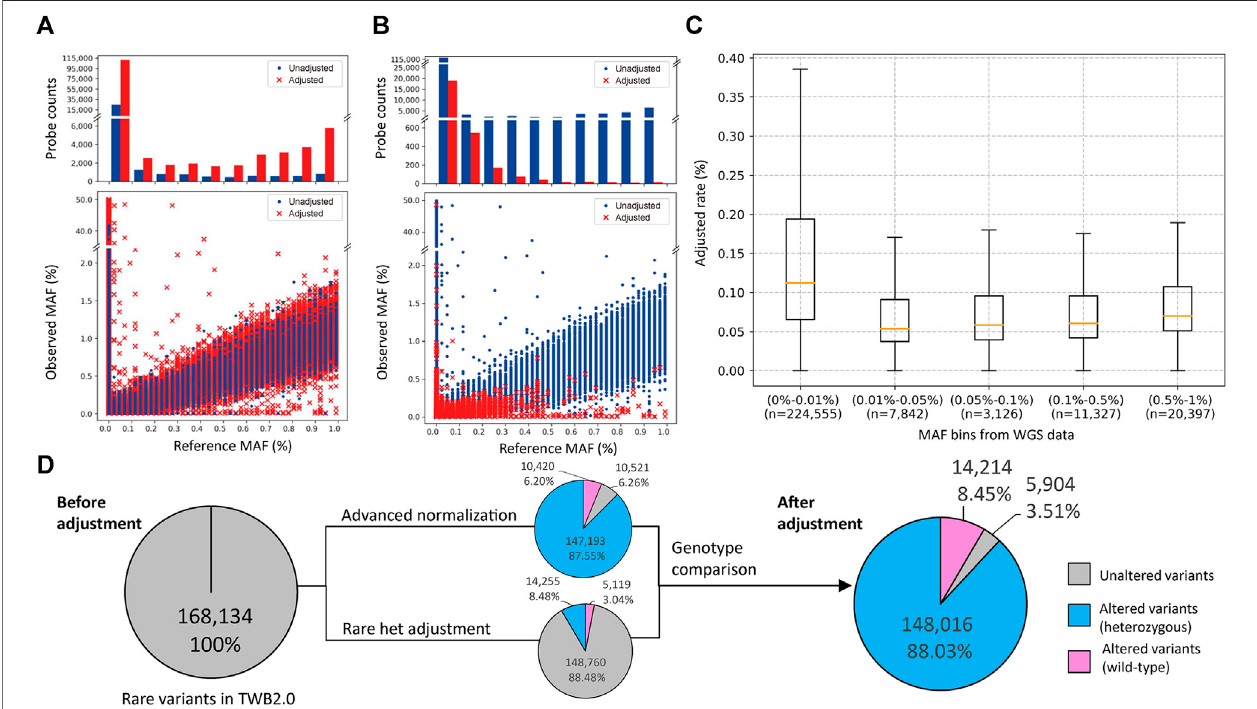
FIGURE 2 | Minor allele frequency (MAF) distribution and probeset count after performance of the rare variant quality-control procedure. (A,B) The former is the MAF distribution after using the advanced normalization method,and thelatter is theMAF distribution after using the rare hetadjustmentmethod. The upper plotshows the number of probesets adjusted (red bar) or unadjusted (blue bar) by this algorithm. The bottom plot shows the distribution of MAFs between the single-nucleotide polymorphism (SNP) array and sequencing data. Adjusted data points are marked with a red “ × ” , and unadjusted data points are marked with a blue dot. (C) Box plot of the adjusted rate per MAF bin based on sequencing data. (D) Number of rare variants with at least one heterozygous call in the original data, and after advanced normalization and rare het adjustment. Variants not adjusted by our algorithms are represented as a gray slice. Variants adjusted by our algorithms are represented as a blue slice. Variants adjusted by our algorithms are represented as a pink